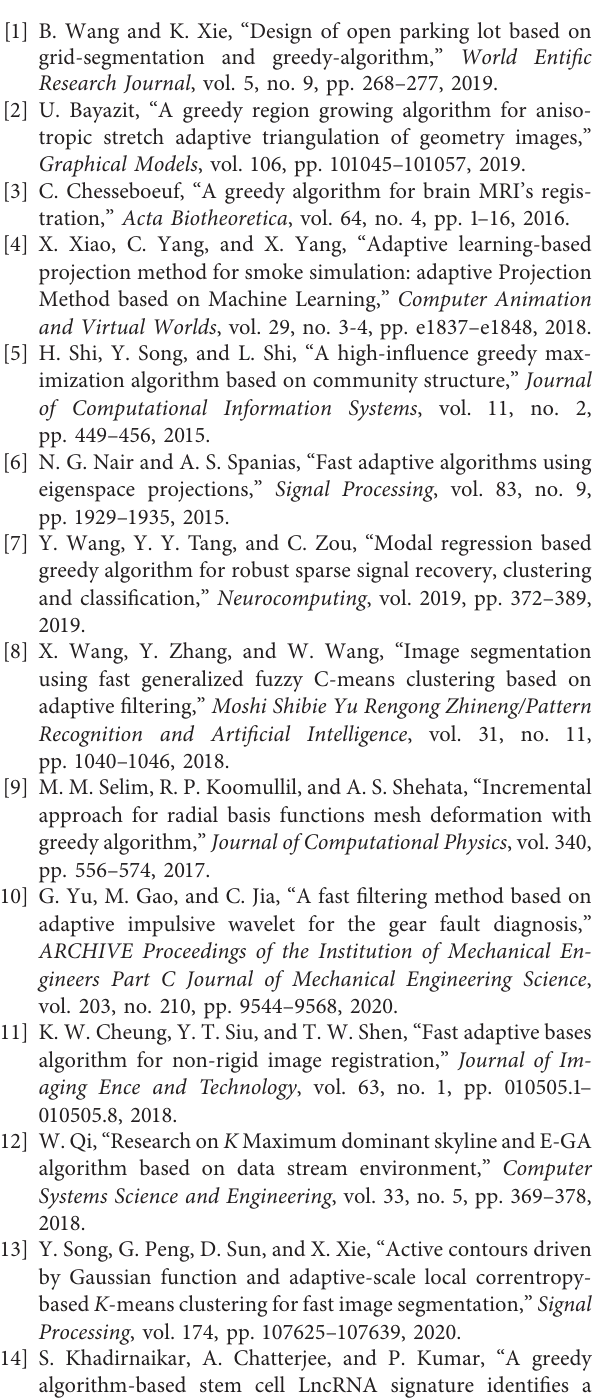
algorithm-based stem cell LncRNA signature identifies a